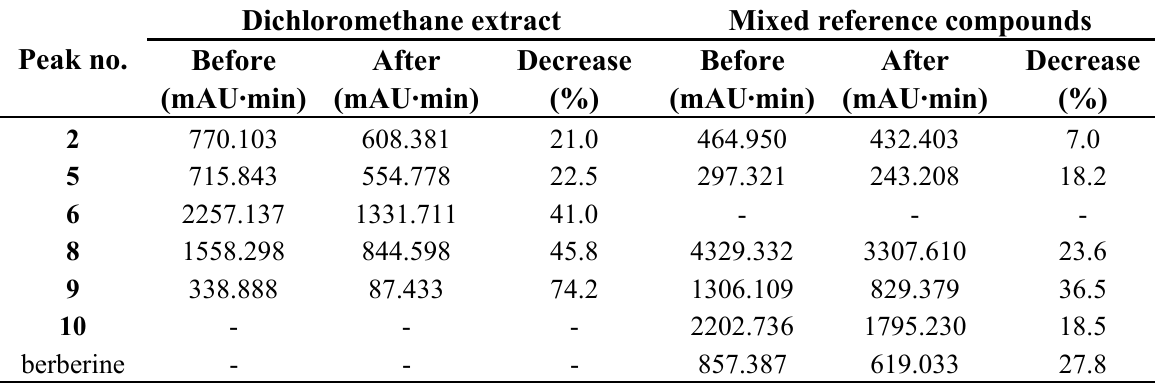
Table 2. Peak areas of compounds before and after incubating with aromatse. Peak